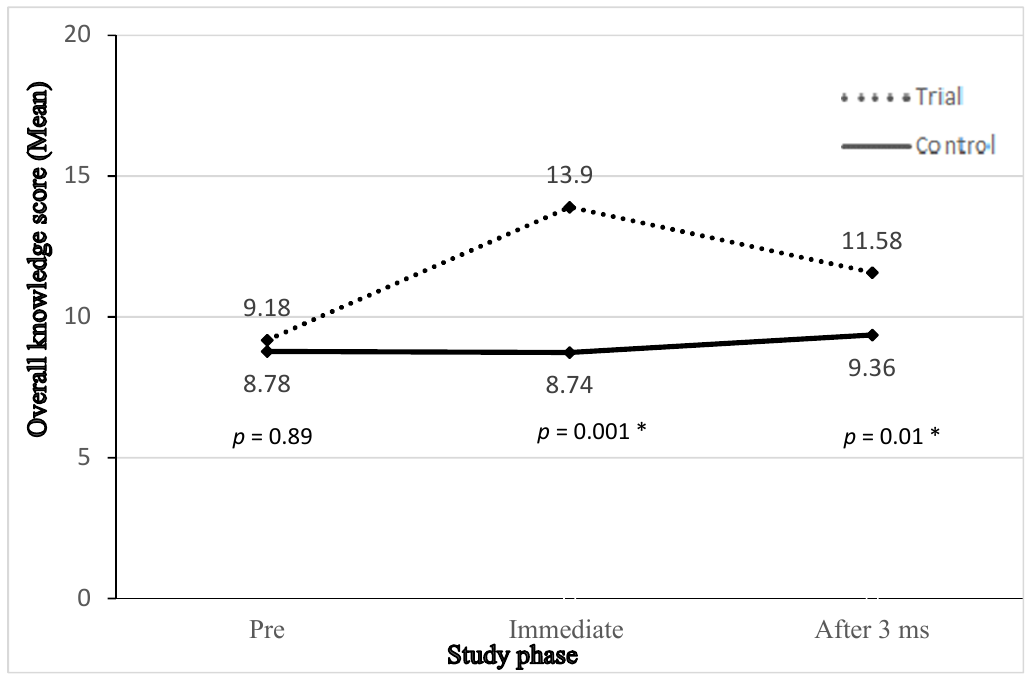
Figure 1. Teachers’ overall knowledge score in trial and control groups at different points of assessment. * Statistically significant ( p < 0.05) .